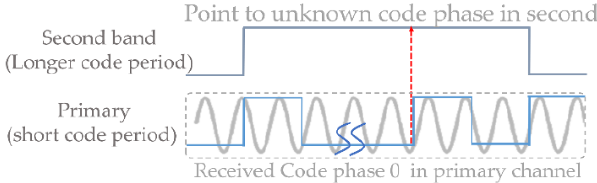
Figure 4. Limitation when different code periods occur in the inner code aiding scheme. The ionospheric delay of each channel is solved as TEC × 40.3 / c f 2 using the Klobuchar algorithm [21,22], which is a curve fitting technique that considers eight inputted Klobuchar coefficients obtained from the navigation messages. This delay was found to be proportional to the TEC and inversely proportional to a square of the carrier frequency f and speed of light c . In this model, the value of 40.3 was the so-call Klobuchar factor [20], which is computed to reduce the ionospheric root mean square range error by 57% [23]. Typical receivers use the aided acquisition in the L2 channel to find the ambiguity to solve ˆ τ L 2 in Equation (5). To reduce time consumption in detecting the ambiguity, the bit-boundary assisted signal alignment is used due to the rising edge of the navigation bits being simultaneously modulated at the same time in the transmitter. As can be seen in Figure 5, the primary tracked bit edge can point to the first chip of the L2CM code. Therefore, the phase of the L2CM code can be determined within the “one-shot” estimation.